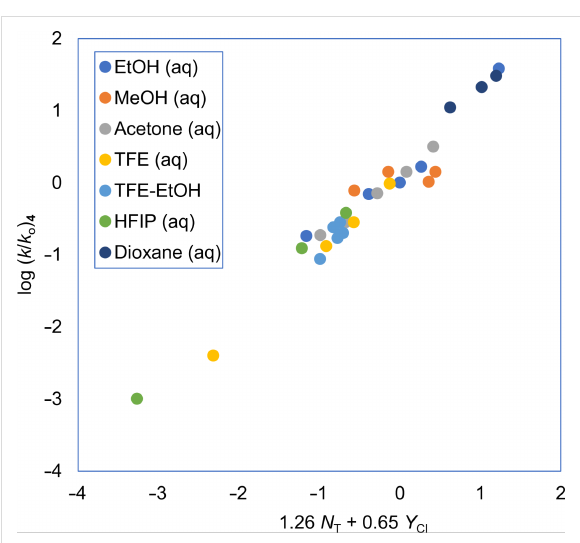
Figure 1: The S N 2 reaction plot of log ( k / k o ) vs (1.26 N T + 0.65 Y Cl ) for the solvolyses of benzesulfonyl chloride ( 4 ) in pure and binary sol- vents at 35.0 °C. Figure 1 was redrawn using the data points from [63] (“Correlation of the Rates of Solvolysis of Two Arenesulfonyl